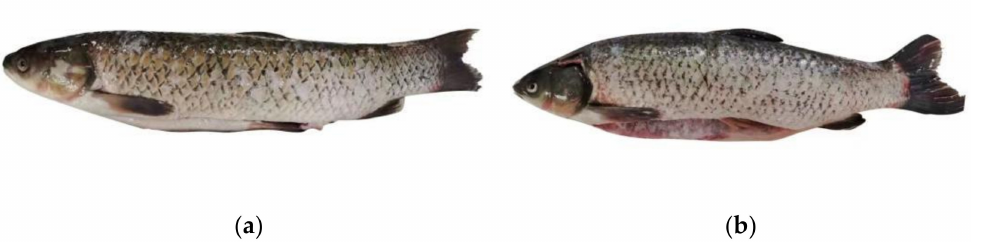
Figure 1. Comparative pictures of ( a ) grass carp from Jingpo Lake (JPGC) and ( b ) commercial grass carp